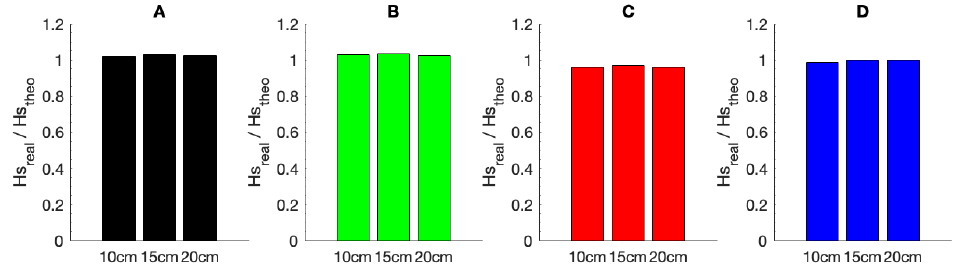
Figure 15. Ratio of realised ( H s T p = 2.58 s, H s = 10 cm, 15 cm, and 20 cm sea-states for facilities ( A – D ).